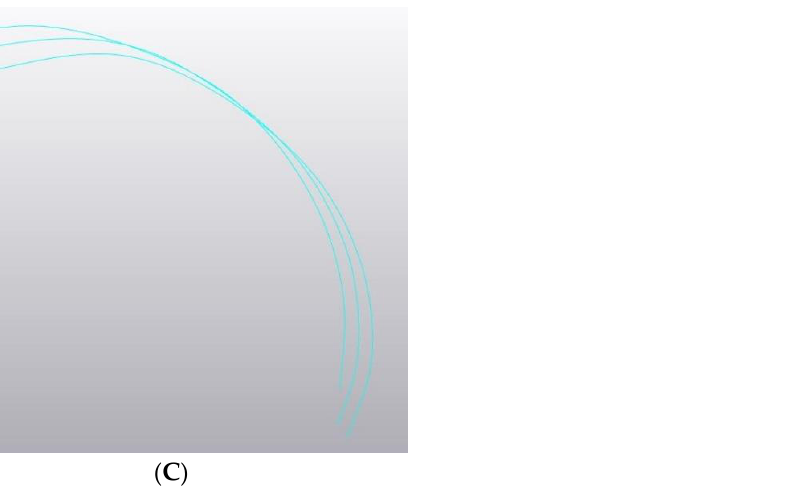
Figure 9. Statistical Shape Model of Patella resected at 6 mm and implanted with a universal patella (Aesculap, Tuttlingen, Germany). The implant peak (red) is 1.6 mm lateralized with respect to the native patella peak (blue). The overhang and underhang of the Vega component are exemplified in Figure 10. This can well be analysed in 3D in all regions of the components.